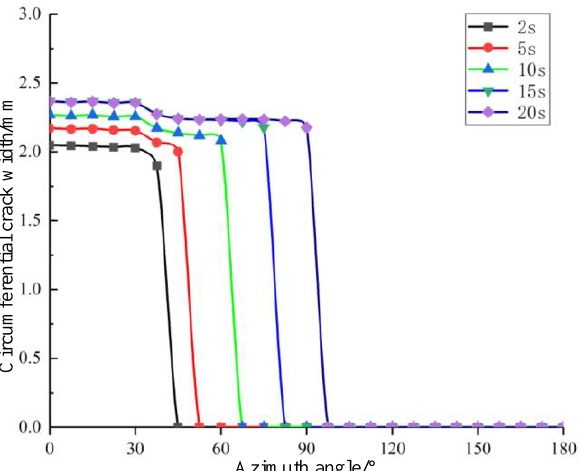
Figure 13. The relationship between the circumferential crack width and azimuth angles at different injection times.